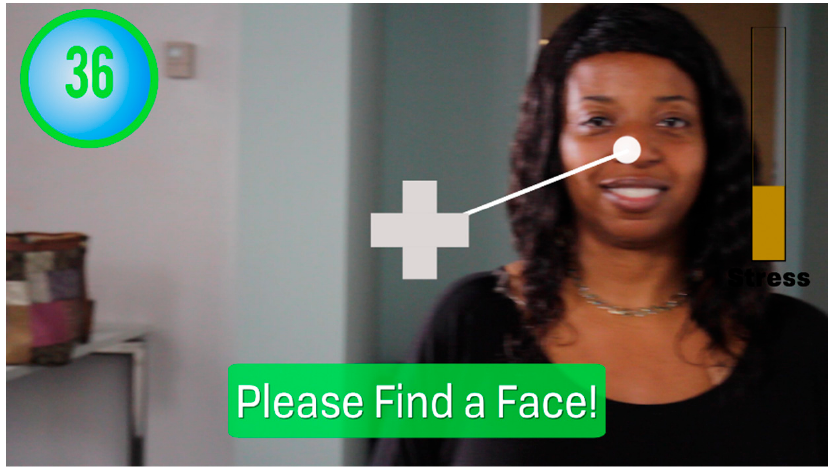
Figure 2. Face2Face module. Representative screen-capture image demonstrating a moment of what a Face2Face user experiences. Face2Face is one of the apps or modules of the Empowered Brain wearable system. This module includes artificial intelligence that finds and tracks faces, and is designed to make an engaging video game-like experience out of learning to direct one’s gaze toward a partner when conversing. Through the computer screen of the wearable smartglasses headset (such as Google Glass), the user gets feedback that encourages face-directed gaze. For instance, in the moment represented here, the user is guided to redirect attention back to the partner’s face via tones, visual words, and a dynamic arrow (drawing on “universal design for learning” by engaging multiple alternative senses and channels of reinforcement simultaneously). When mutual gaze is re-established, the user continues to earn points, stars, and temporary cartoon facemasks for achievement levels.